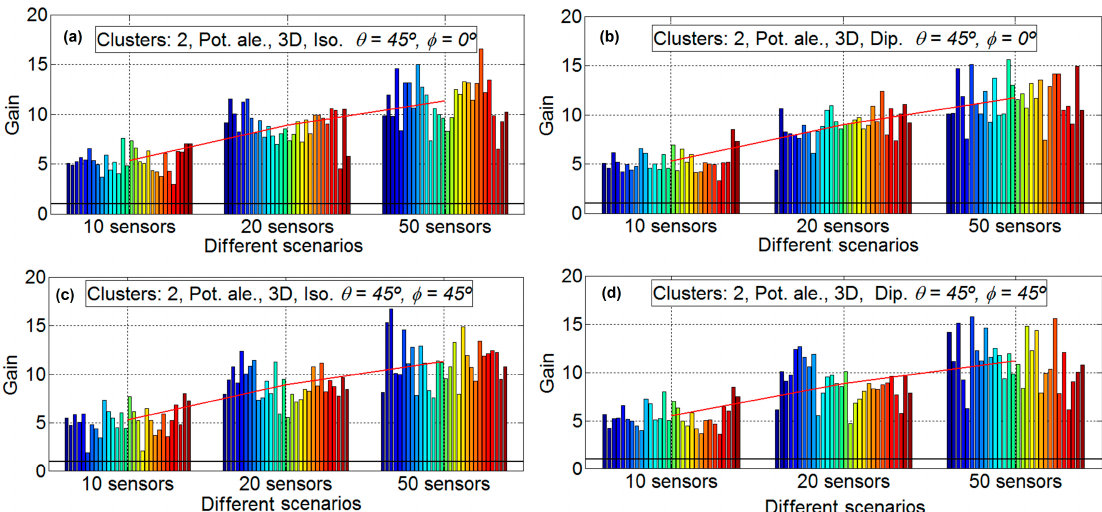
Figure 9. Gain results with two clusters, 10, 20 and 50 sensors, Scenario D. Isotropic antenna φ = 0 ◦ and θ = 45 ◦ in subfigure ( a ) ( upper left ), dipole antenna, φ = 0 ◦ and θ = 45 ◦ in subfigure ( b ) ( upper right ), isotropic antenna, φ = 45 ◦ and θ = 45 ◦ in subfigure ( c ) ( lower left ) and dipole antenna, φ = 45 ◦ and θ = 45° in subfigure ( d ) ( lower right ).